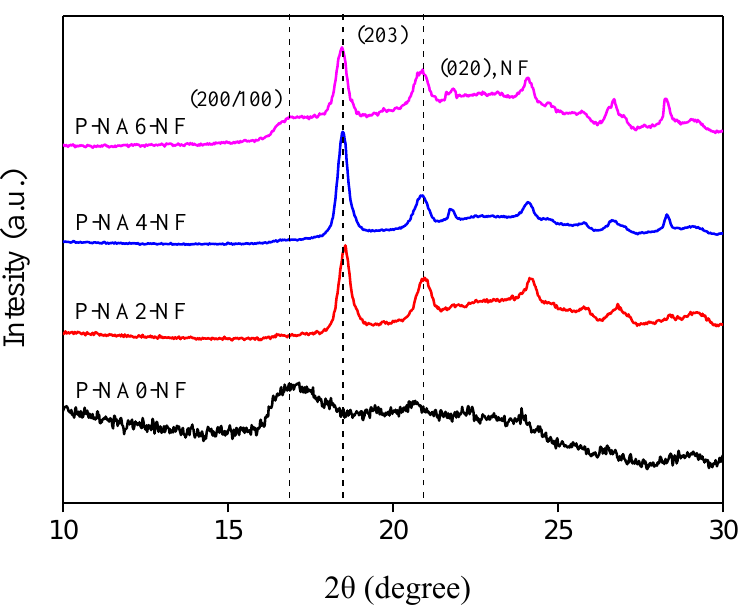
Figure 3. XRD patterns of the NF-reinforced PLA composites with different NA contents.